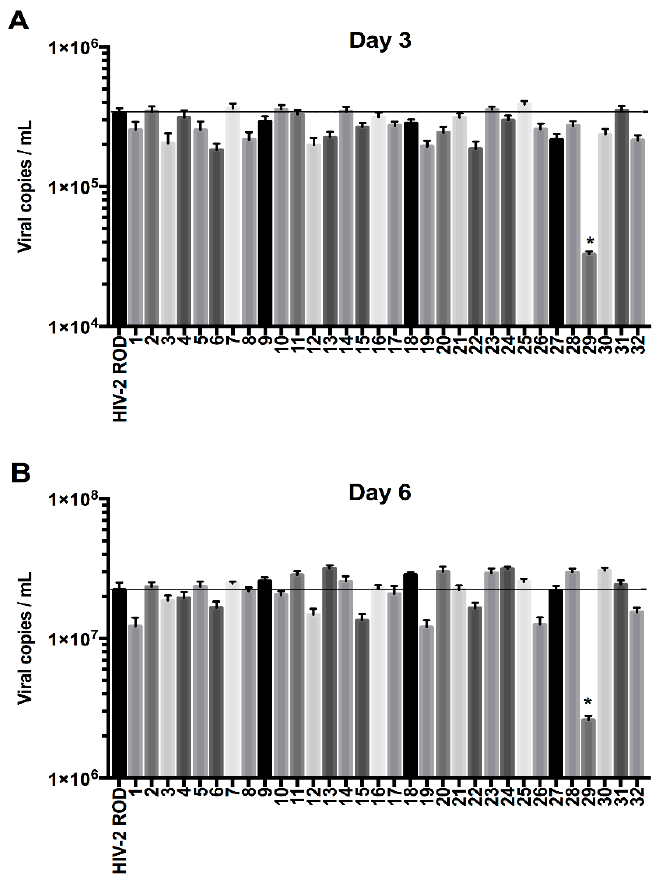
Figure 2. Absolute quantification of viral release ability among thirty-two HIV-2 Env mutants. The different clones were generated by site-directed mutagenesis and transfected in HEK293T cells. The viral particles were then used to infect H9 cells, a BST-2 producing cell line. Quantification was performed at three ( A ) and six ( B ) days post-infection ( n = 3 independent experiments). The mutant numbers 1 to 32 are the same as highlighted substitutions in Figure 1B. The HIV-2 Env N659D mutant (mutant 29) showed a lower viral release compared to the HIV-2 Env WT. Error bars indicate mean ± standard deviation (SD) and statistical tests give statistical significance with a p < 0.05 (*).